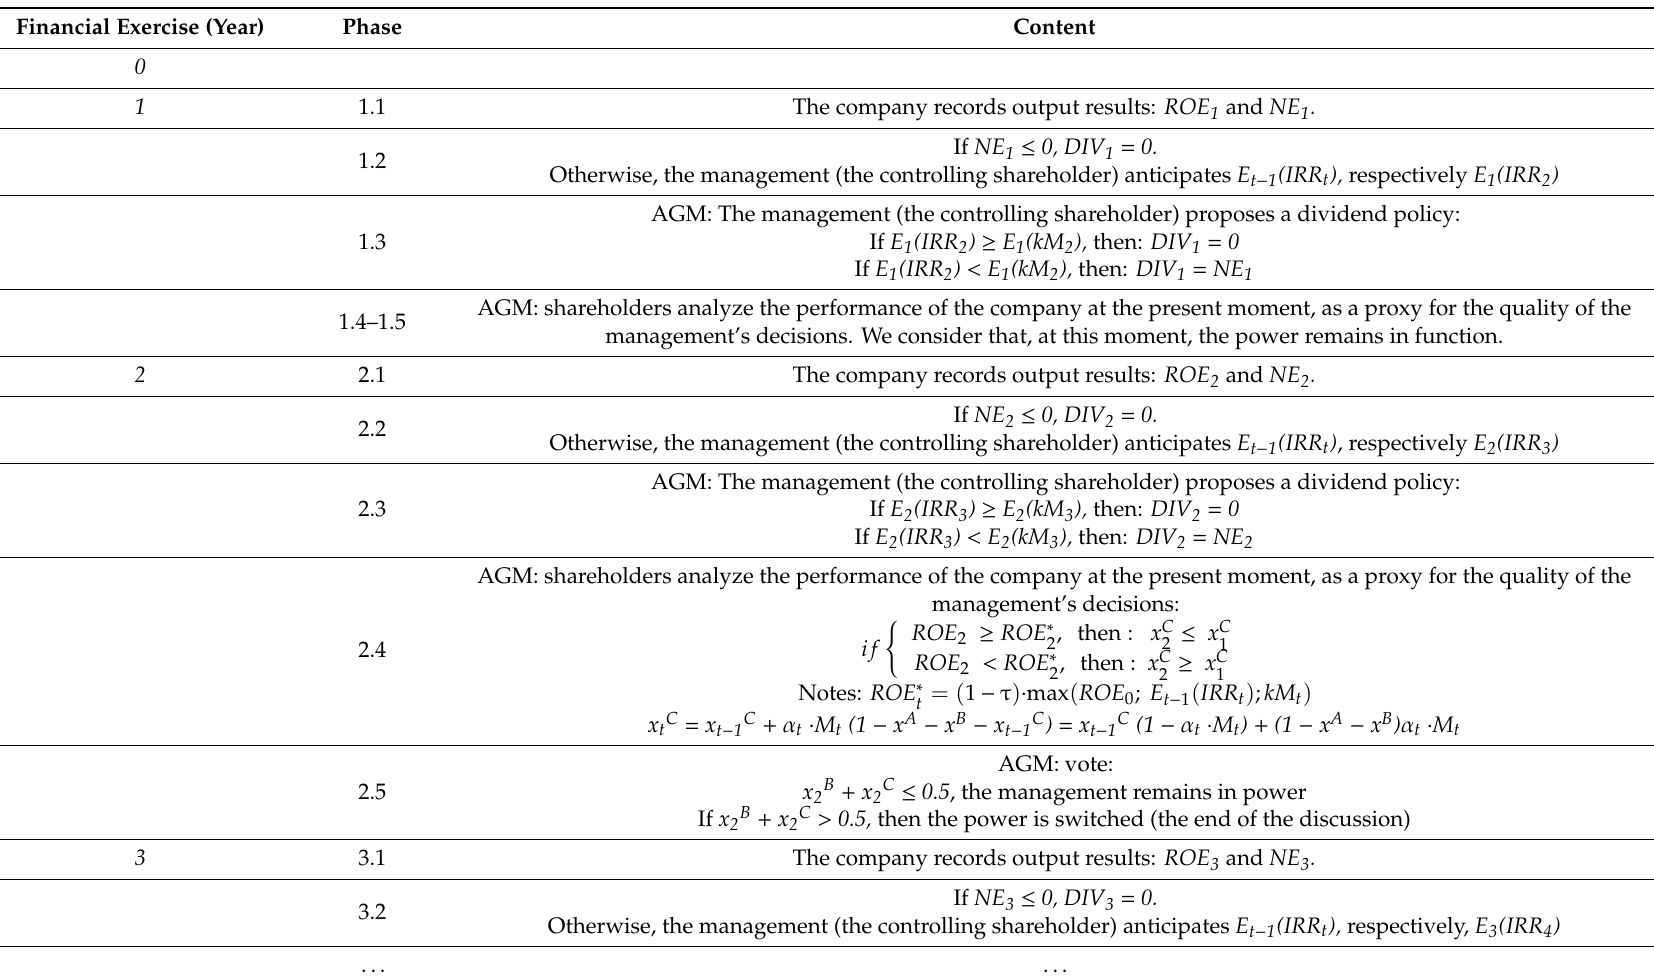
Table 2. The sequence of the decision-making